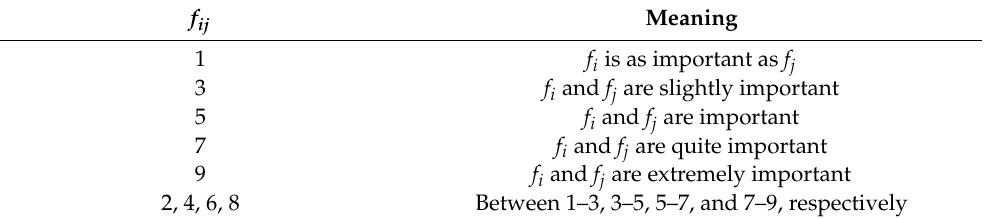
Table 3. We use the Delphi method to construct the judgment